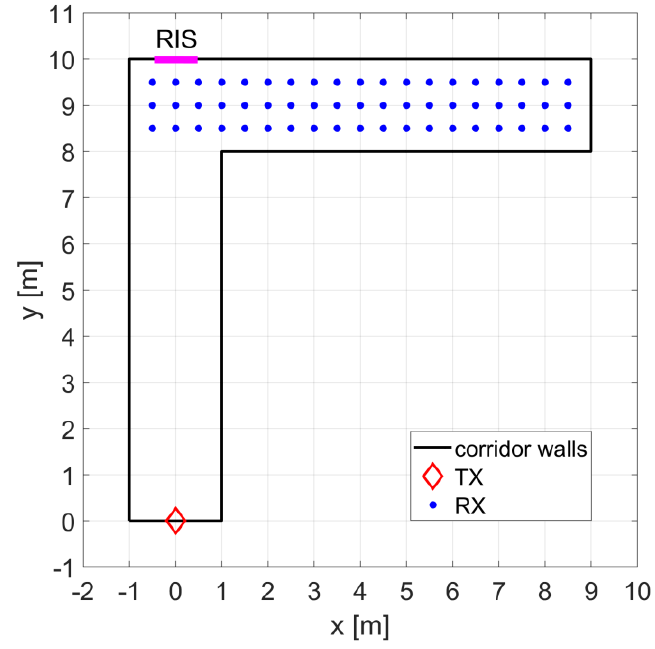
Figure 2. L − shaped corridor with TX/RX locations, and the RIS. Figure 2. L–shaped corridor with TX/RX locations, and the